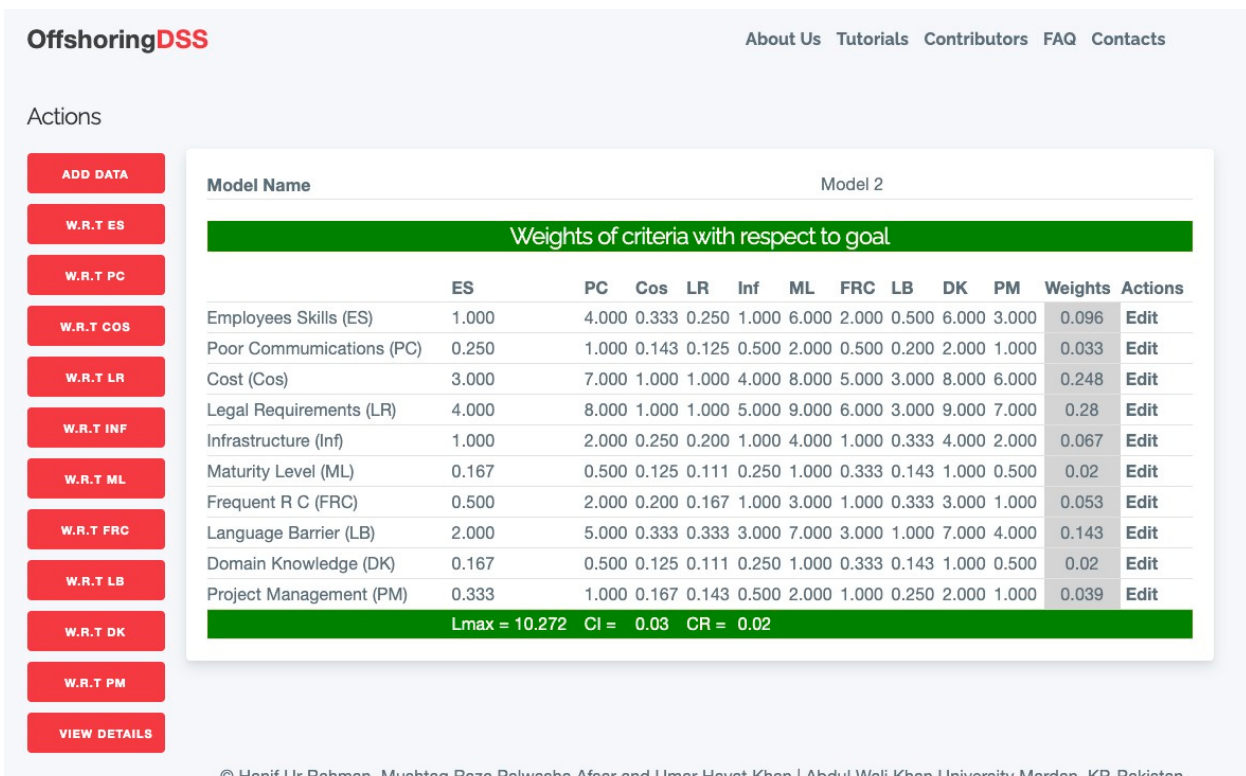
Figure 9. Weights of criteria with reference to the goal.